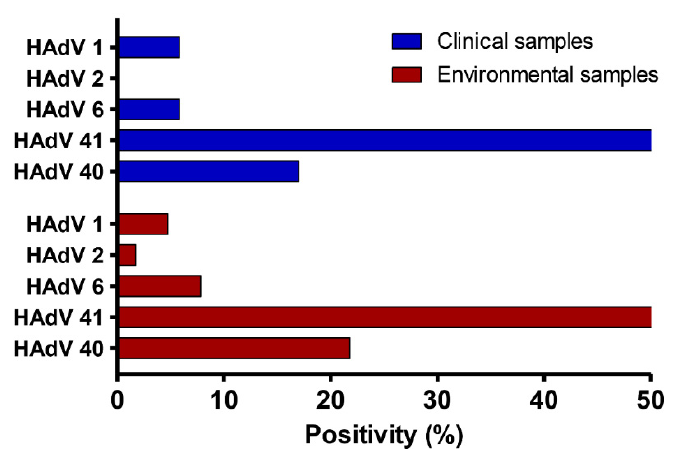
Figure 3. Distribution of HAdV genotypes in both fecal and sewage samples during a five-year period from 2016 to 2020. Table 4. Environmental positive HAdV genotypes distribution in raw and treated samples from